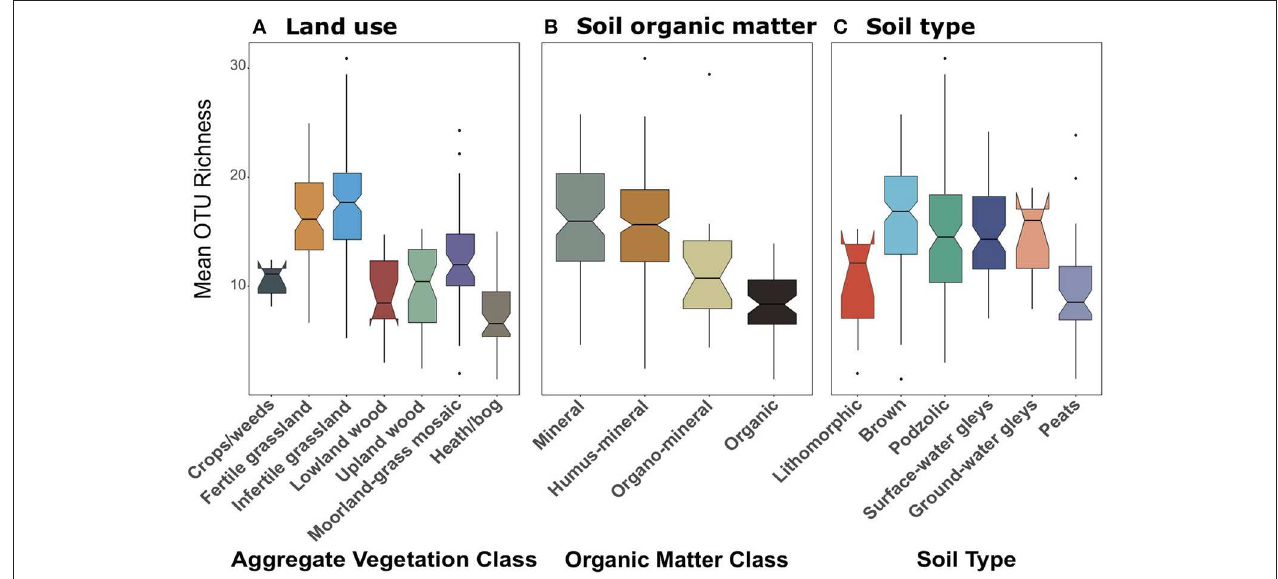
FIGURE 10 | Boxplots of richness of Glomeromycetes OTUs plotted against (A) Aggregate Vegetation Class; (B) organic matter class; (C) soil type. Aggregate Vegetation Classes are ordered from most (Crops/weeds) to least (Heath/bog) productive. Organic matter classes are listed in order of increasing percent organic matter. Soils are listed in increasing order of moisture retention. Boxes cover the first and third quartiles and horizontal lines denote the median. Black dots represent outliers beyond the whiskers, which cover 1.5X the interquartile range. Notches indicate confidence interval around the median. Overlapping notches are a proxy for non-significant differences between medians. Black dots are